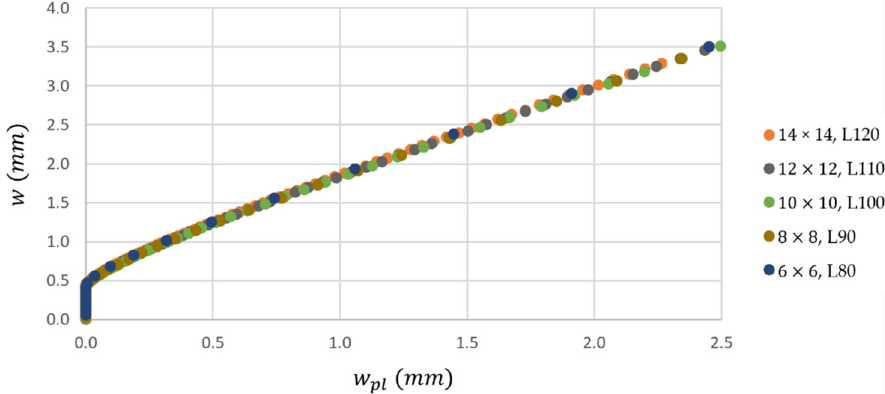
Figure 4. The dependency of total deflection on plastic deflection from the numerical study concerning optimal distances of supports ( L in the legend) for each cross-section size D × D.